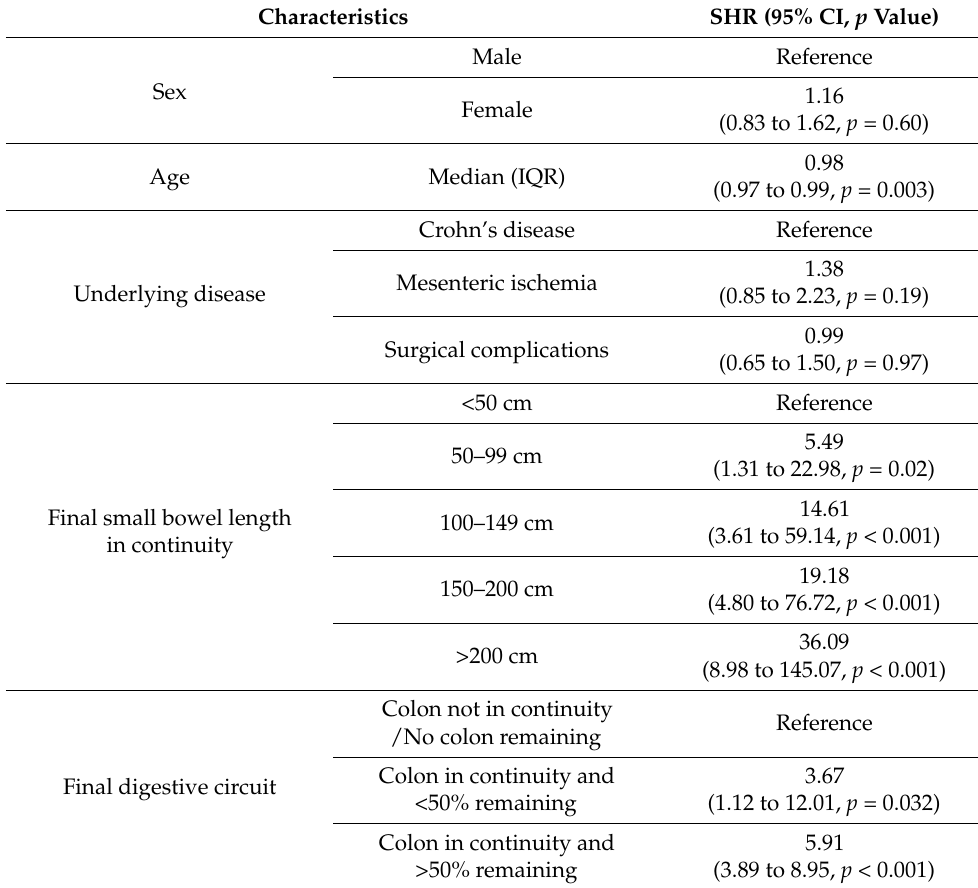
Table 2. Fine and Gray regression of nutritional